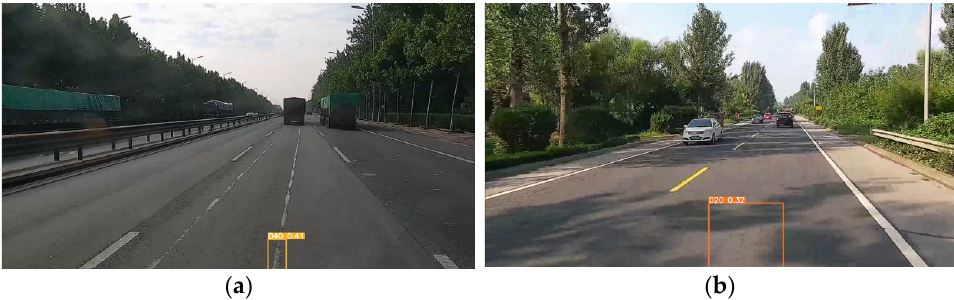
Figure 8. False detection results of pavement cracks: ( a ) longitudinal crack was mistakenly detected as pothole; ( b ) longitudinal crack was mistakenly detected as alligator crack.